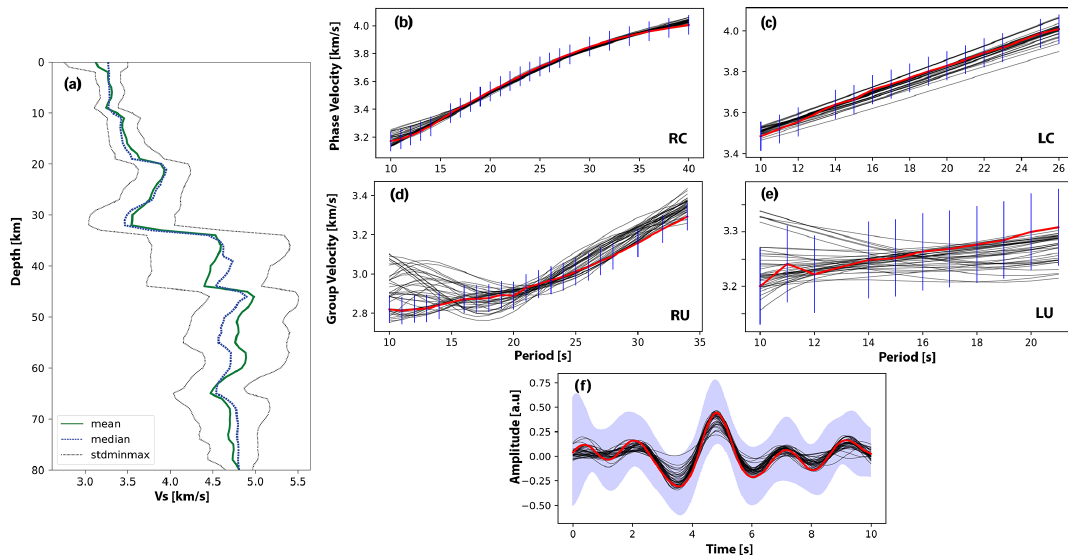
Figure 9. Illustrative example of 1D shear-wave velocity inversion. (a) The green line represents the mean, the blue dots the median and the gray lines the standard deviation estimated for the 1D shear-wave velocity model at 7.0 ◦ N, 65.0 ◦ W (corresponding to the Guiana Shield), from the ensemble of the best models per chain. (b, d) Phase and group velocity fit (gray line is the fit per chain) of the Rayleigh wave; (c, e) phase and group velocity fit of the Love-wave; (f) receiver function of the MAPC station, which was used to do the 1D shear-wave inversion. The red line is the observed dispersion curves and receiver function, blue bars correspond to an error of 3 standard deviations, and the purple shadow is the associated error of the receiver